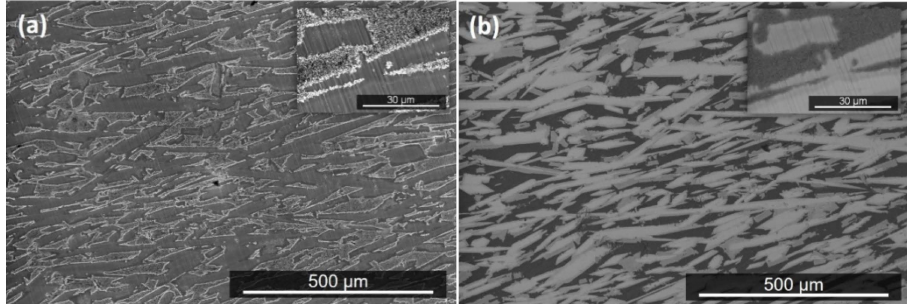
Figure 8. Scale of the alloy OHC2 after isothermal oxidation at 800 ◦ C for 100 h: ( a ) SE image, ( b ) BSE